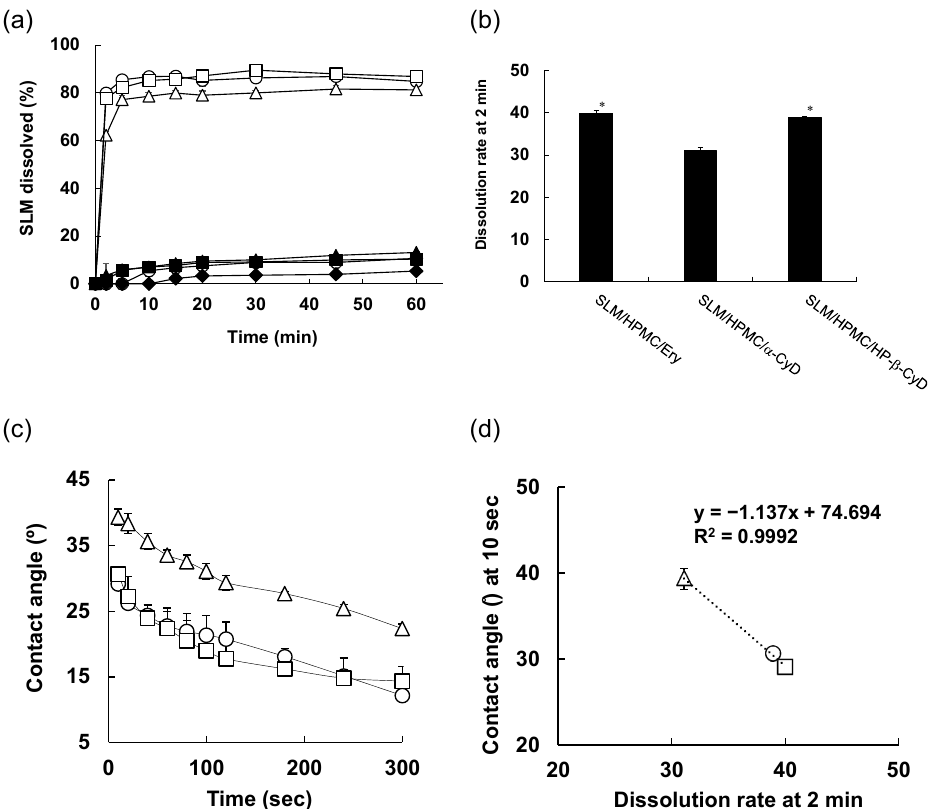
Figure 3. Dissolution behavior ( a , b ), Contact angle ( c ) and Correlative Evaluation ( d ) of various silymarin/hypromellose nanoparticles (SLM/HPMC NPs). ◆ : SLM original, ● : SLM/HPMC/erythritol (Ery) PM (1/1/1), ▲ : SLM/HPMC/ α -cyclodextrin( α -CyD) PM, ■ : SLM/HPMC/HP- β -CyD PM, 〇 : SLM/HPMC/Ery NPs, △ : SLM/HPMC/ α -CyD NPs, □ : SLM/HPMC/HP- β -CyD NPs. The weight ratio of SLM/HPMC/stabilizers was 1/1/1. ( a ) Dissolution behavior up to 60 min. ( b ) Dissolution behavior up to 2 min. * p < 0.05, compared with SLM/HPMC/ α -CyD NPs. ( c ) Contact angles of SLM/HPMC/Ery NPs, SLM/HPMC/ α -CyD NPs, and SLM/HPMC/HP- β -CyD NPs. ( d ) Correlative evaluation between dissolution rate and contact angle of SLM/HPMC/Ery NPs, SLM/HPMC/ α -CyD NPs, and SLM/HPMC/HP- β -CyD NPs. Data represent the mean ± SE of three experiments.